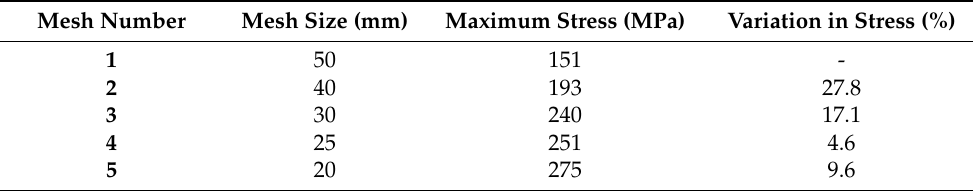
Table 4. Mesh size and maximum stress on the body of the bowser.